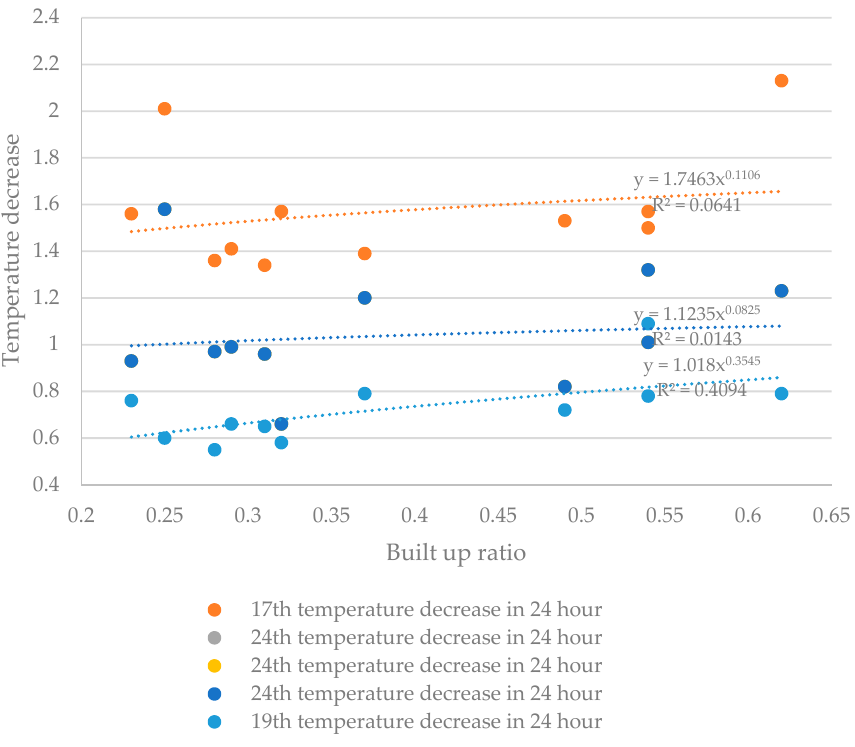
Figure 14. Average hourly temperature decreases in layout and built-up ratio during the 24-h cycle in the three summer days.